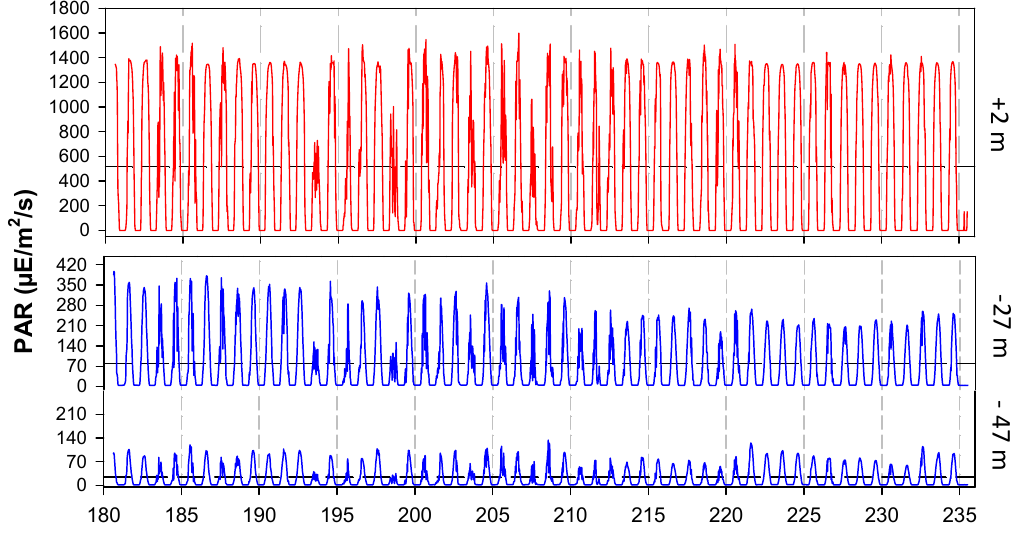
Figure 6. Photosynthetically Available Radiation (PAR; 400–700 nm) measured in the air and at the pelagic water layer above 50 m depth at the OOCS station in summer 2011 ( i.e. , from 30 June to 24 August). The horizontal dashed line depicts the average measurement over the entire period of data acquisition (mean values are: 520 µE/m 2 /s at +2 m; 81 µE/m 2 /s at − 27 m; and finally 18 µE/m 2 /s at − 47 m).